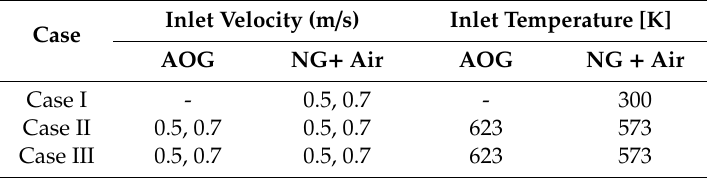
Table 3. Inlet parameters used in the simulations for all the three